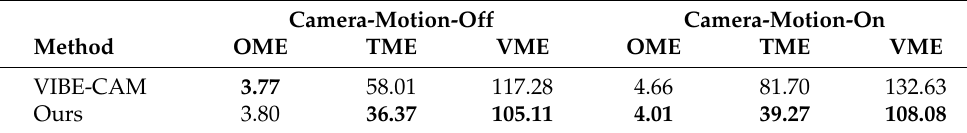
Table 9. Quantitative comparison between the proposed method and VIBE-CAM on the synthetic dataset. Camera-motion-off indicates the synthetic video created without camera motion, while Camera-motion-on means the synthetic video with camera motion. The best results are shown in